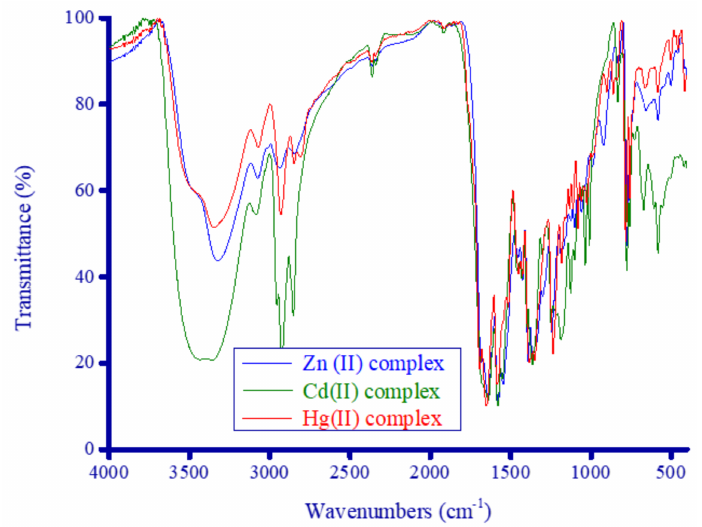
Figure 6. IR spectra of the synthesized metal